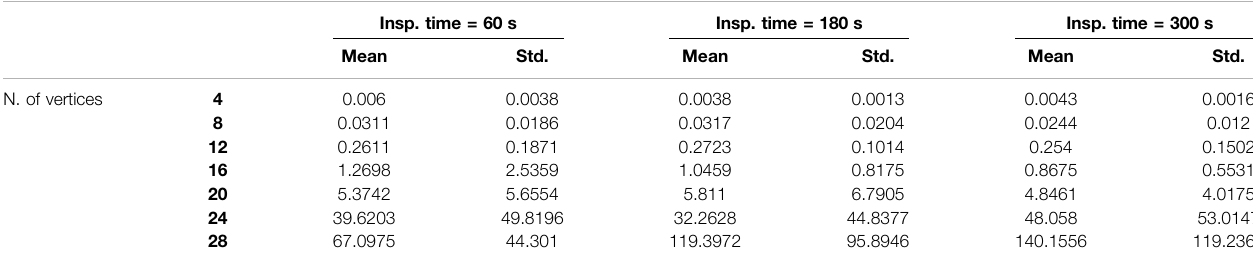
TABLE 2 | First test sumarized results.